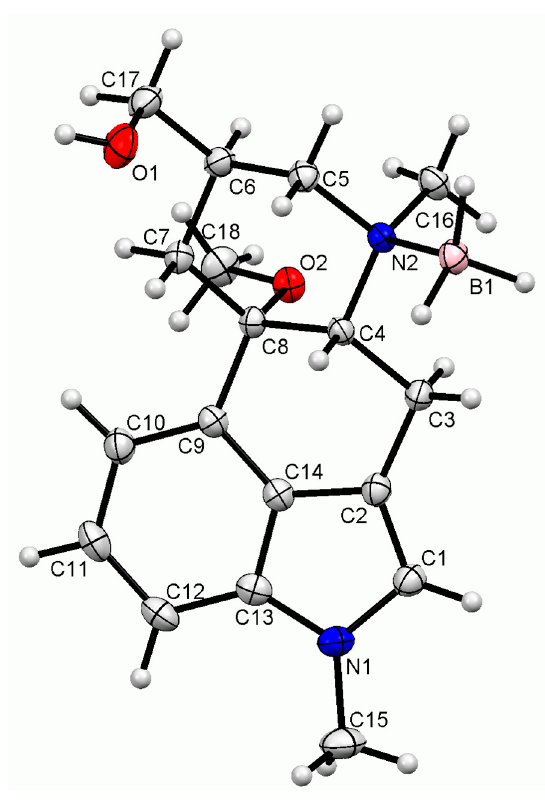
Figure 3. ORTEP drawing of BH 3 -MeLuol ( 4 ) with atomic numbering, ADP drawn at 50% probability level.